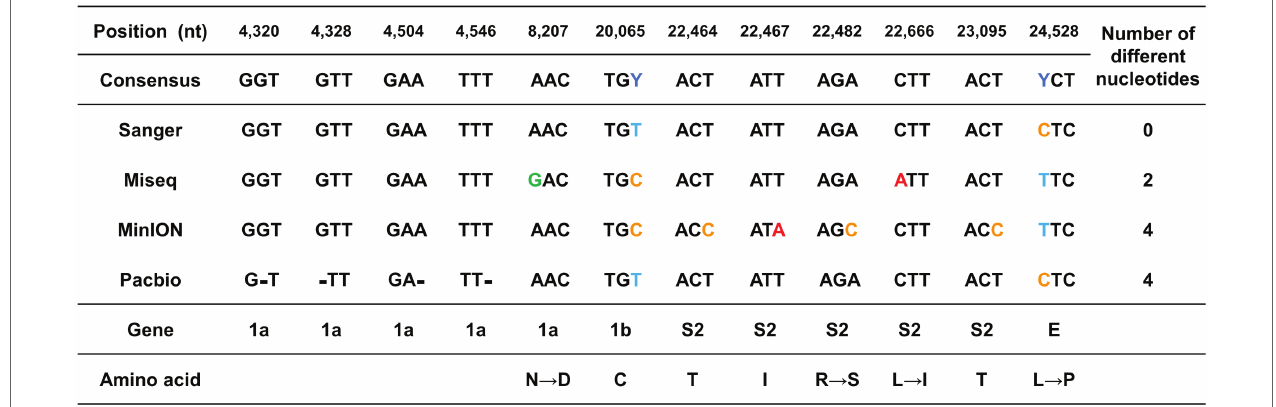
FIGURE 2 | Graphical summary of the sequencing errors observed in this study. The genome sequences produced by each sequencing platform were compared against the consensus sequence. The nucleotide positions with sequence heterogeneity are marked in colored blocks. Dashes indicate gaps in the sequence of one genome relative to its